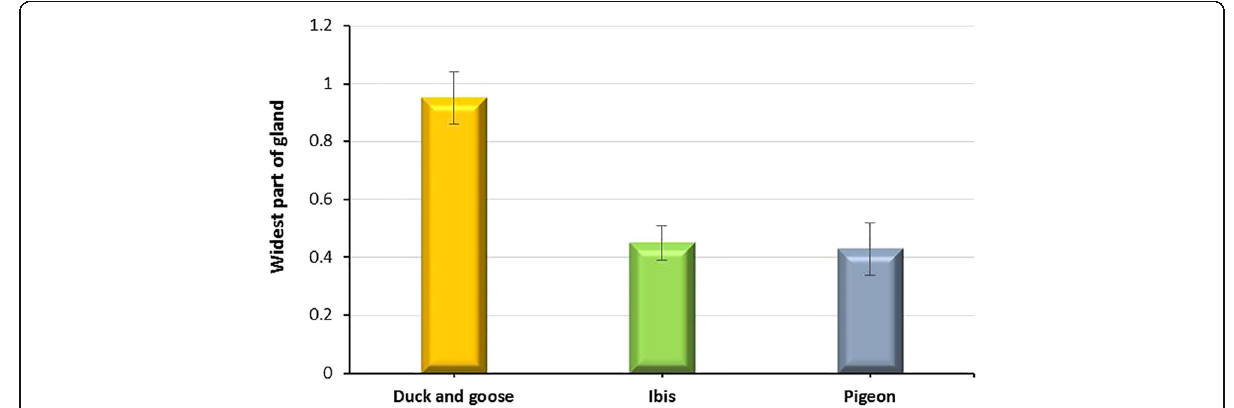
Fig. 5 Descriptive statistics of mean ± SD of widest part of HG in adult duck, goose, ibis, and